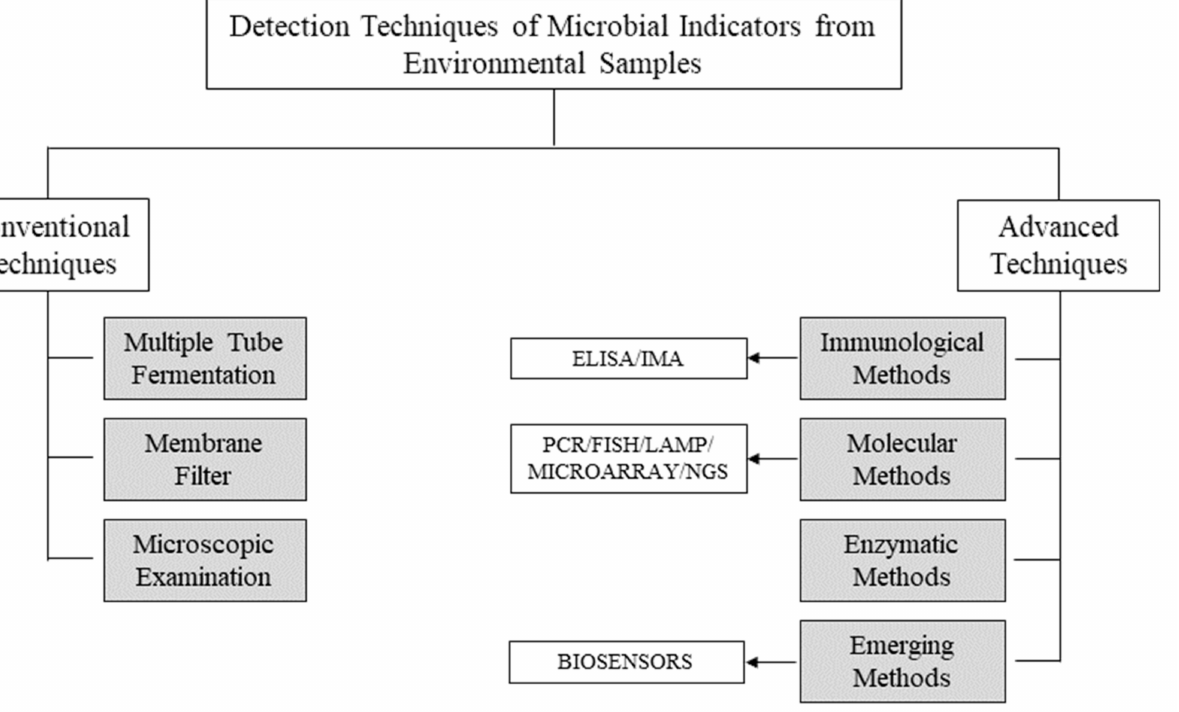
Figure 1. Schematic diagram for conventional and advanced laboratory-based techniques used for monitoring microbial pathogens in environmental samples. ELISA: enzyme-linked immunosorbent assay; IMA: immunomagnetic assay; PCR: polymerase chain reaction; FISH: fluorescent in-situ hybridization; LAMP: loop-mediated isothermal amplification; NGS: next generation